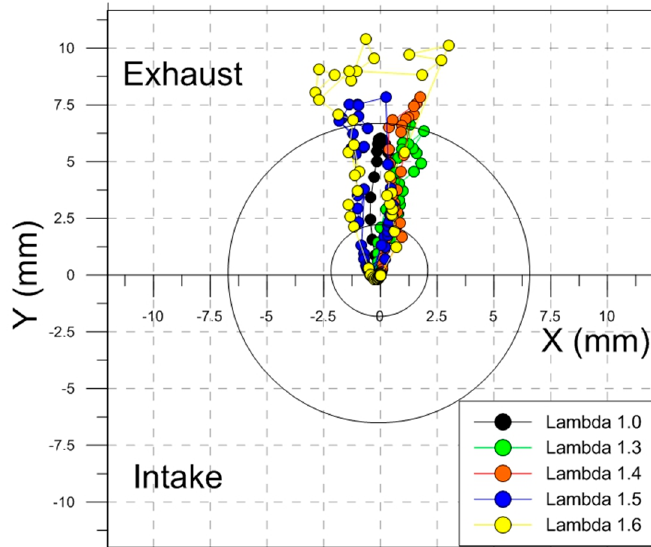
Figure 14. Evolution of the luminous centroid with respect to geometrical center of the combustion chamber; each step of the path is obtained by averaging data over 25 consecutive engine cycles.